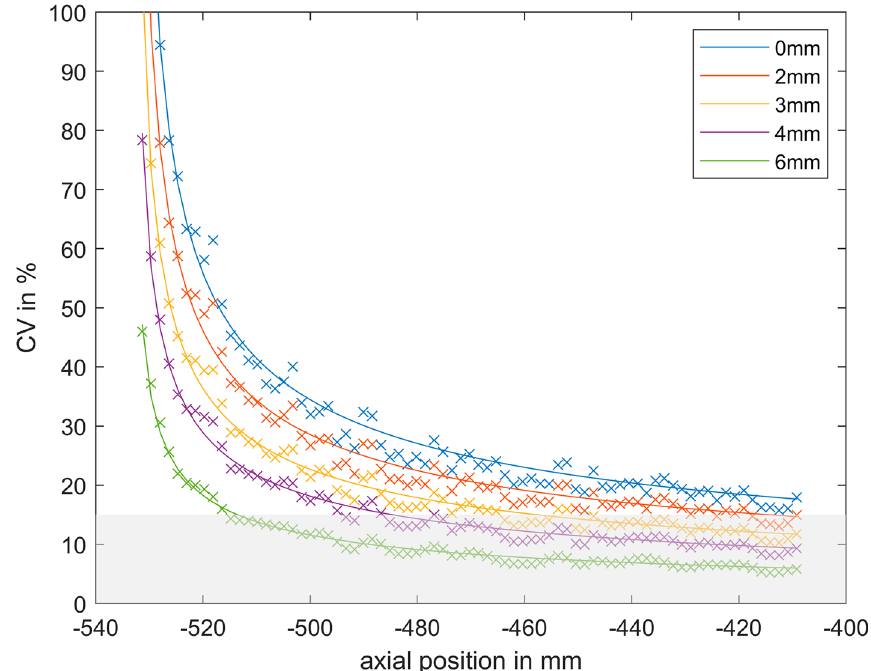
Fig. 3 Example of the fit functions of axial dependence of CV [%] at POS-505 for 120 s acquisition with different Gaussian filters. The legend shows the FWHM of the Gaussian filter. The grey area shows the area < 15% background